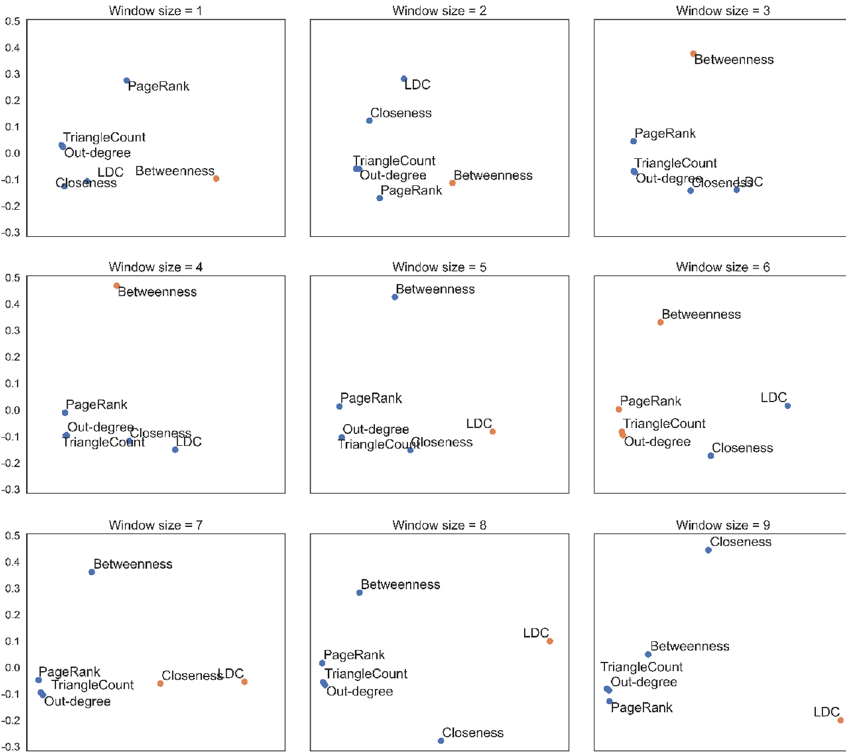
Fig. 5 Analysis on nine correlation matrices. Each color denotes a different cluster. The x-axis and y-axis are PC-I and PC-II, respectively. Each plot represents a space for a given WS value, and MS was equal to 13 in all